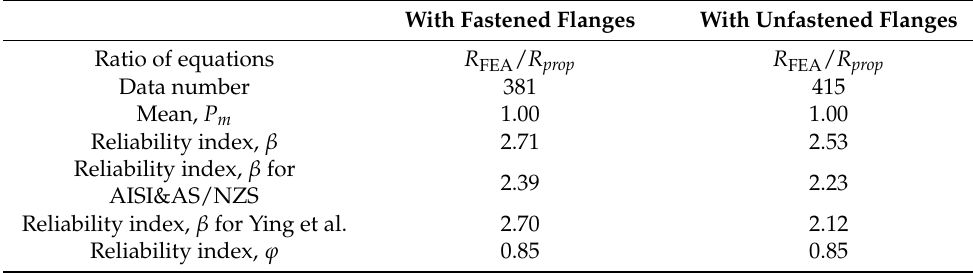
Table 8. Reliability analysis results (centered-hole sections).